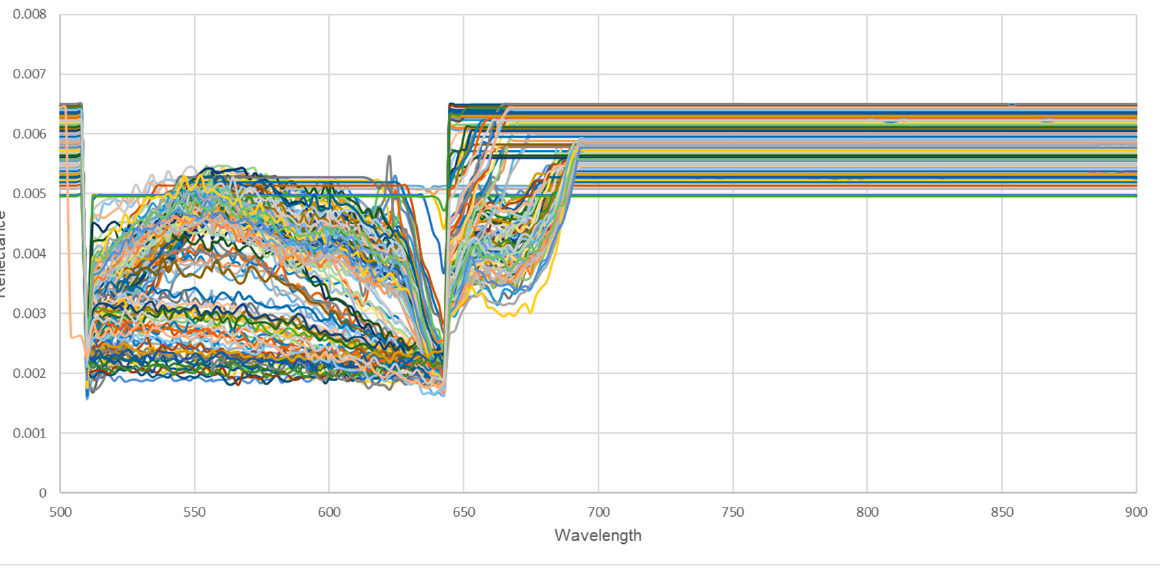
Figure 3. The raw spectral data from random samples of peach leaves.